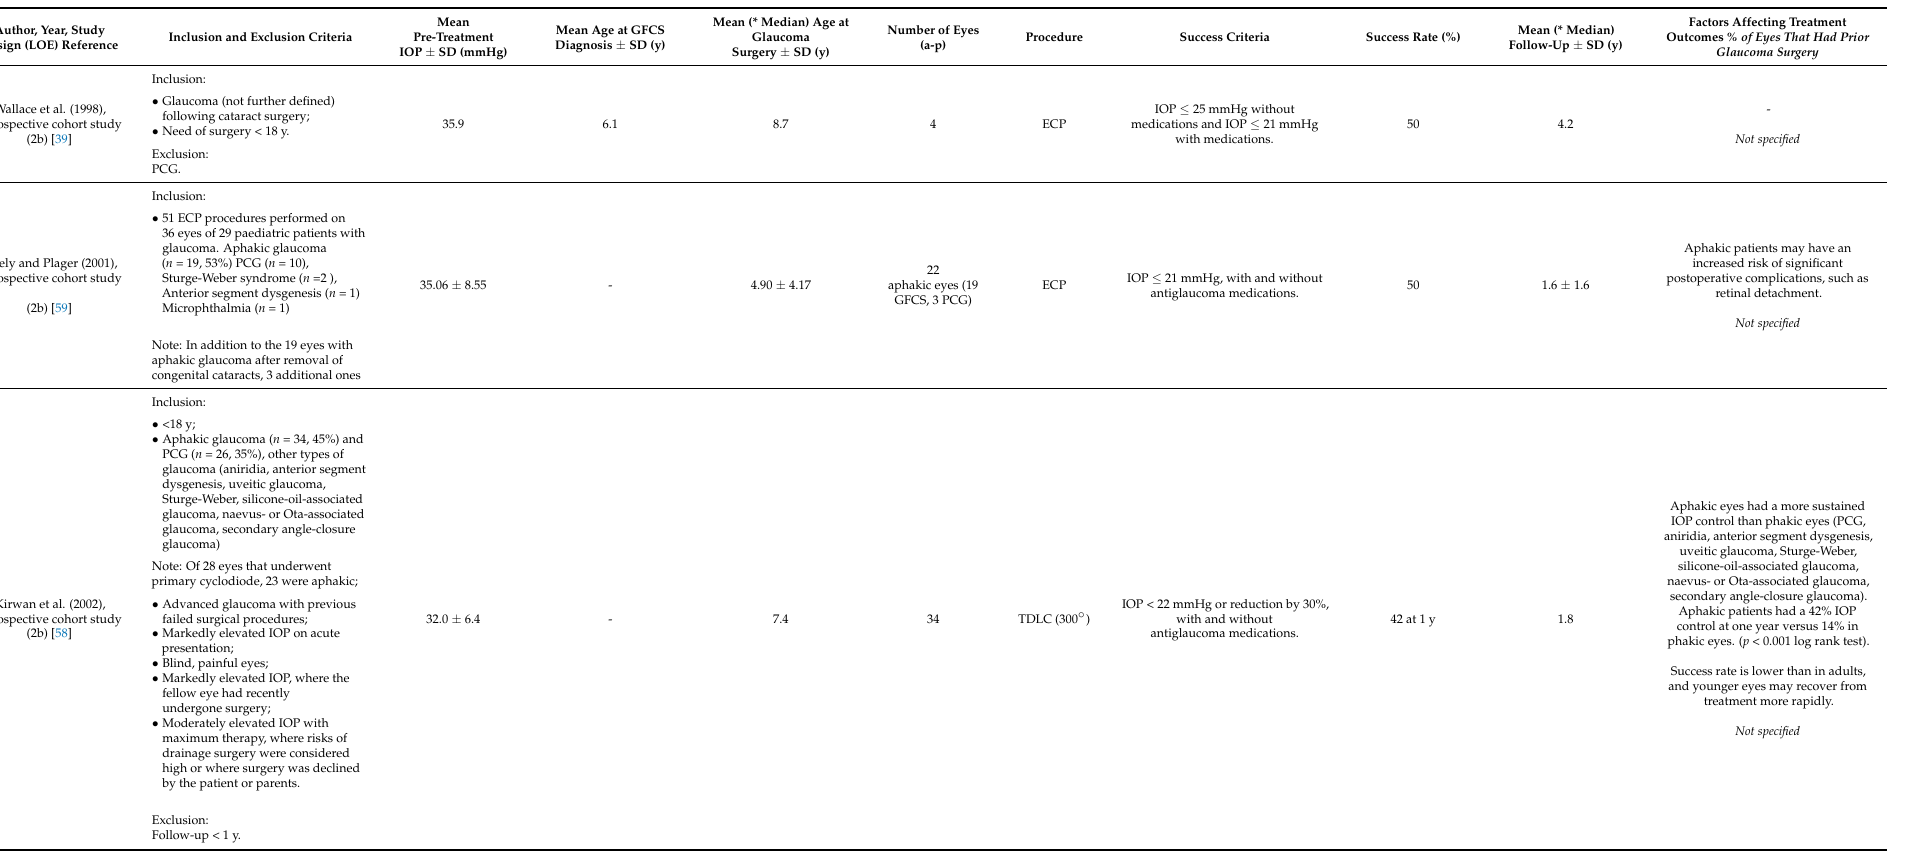
Table 5. Relevant studies involving cyclodestruction in GFCS